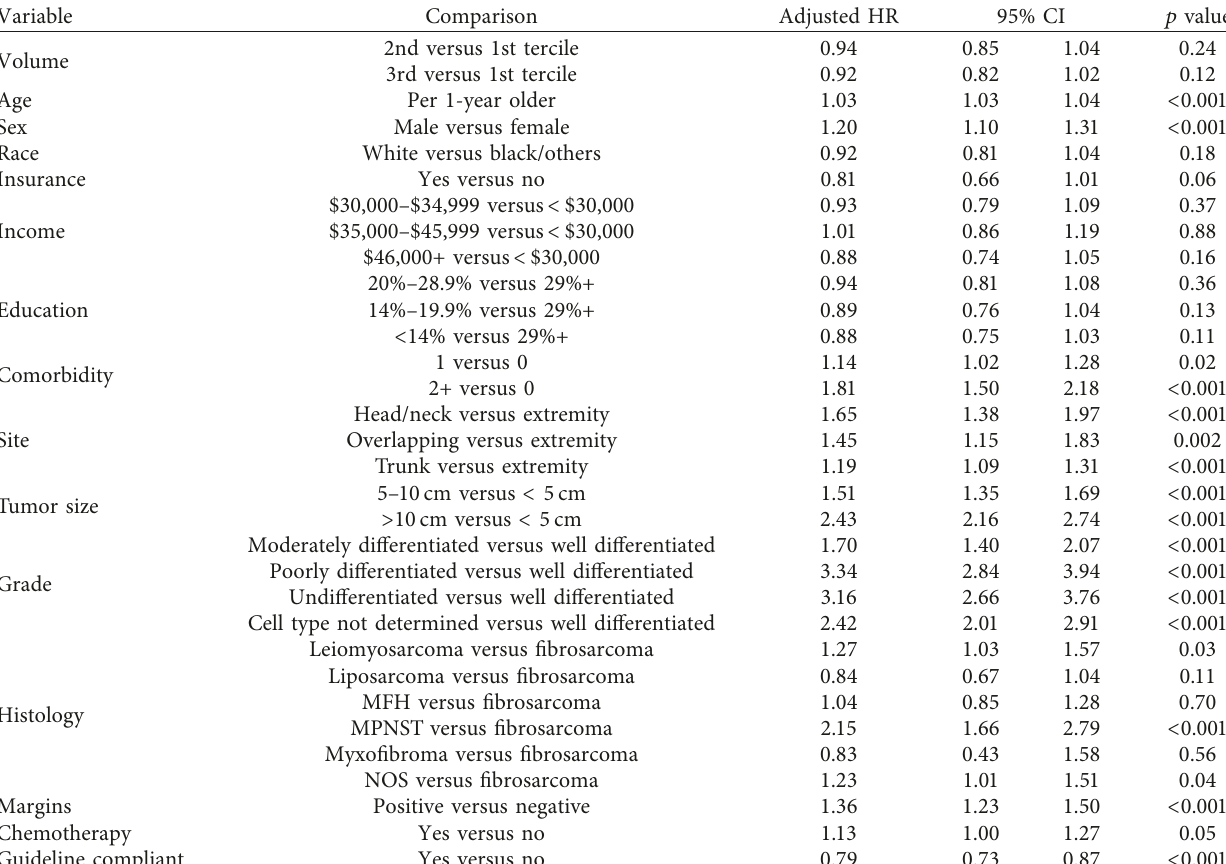
Table 3: Multivariable analysis for overall